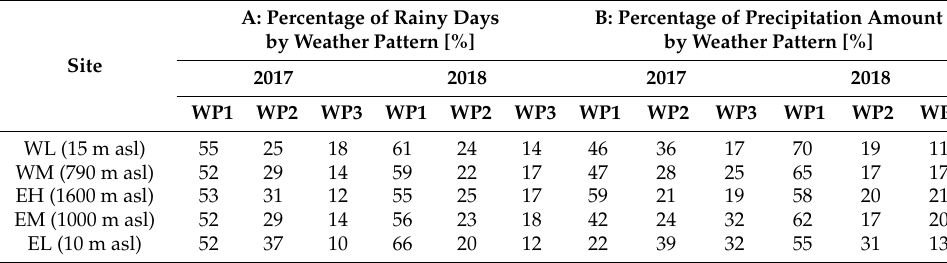
B: Percentage of Precipitation Amount by Weather Pattern